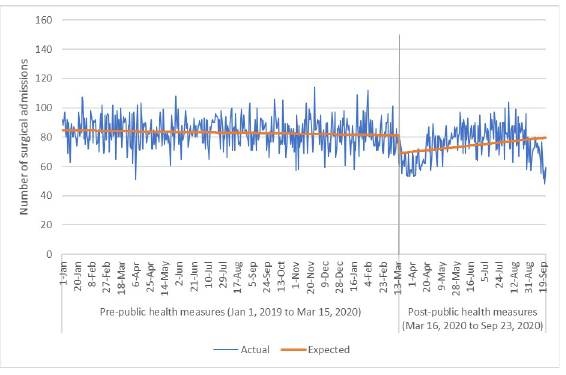
Fig 2. Number of surgical hospital admissions via the emergency department per day.